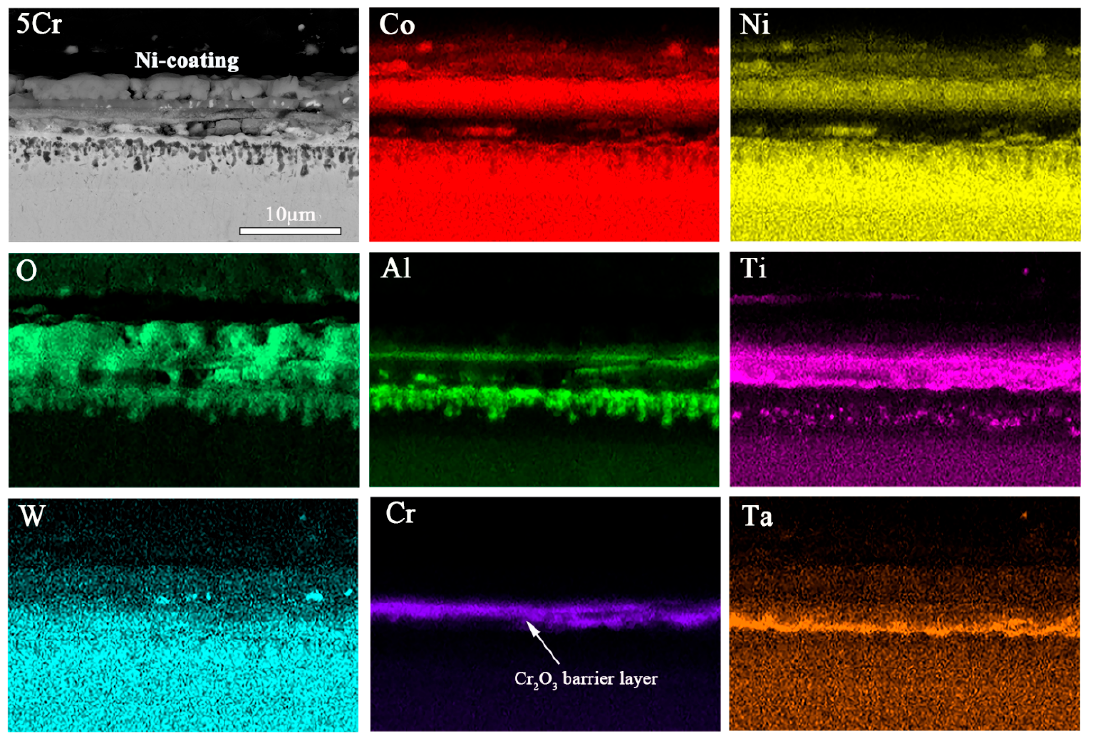
Figure 9. SEM micrographs and EDS mappings of Co-30Ni-10Al-4W-4Ti-2Ta-5Cr alloy oxidized at 900 °C for 100 h.